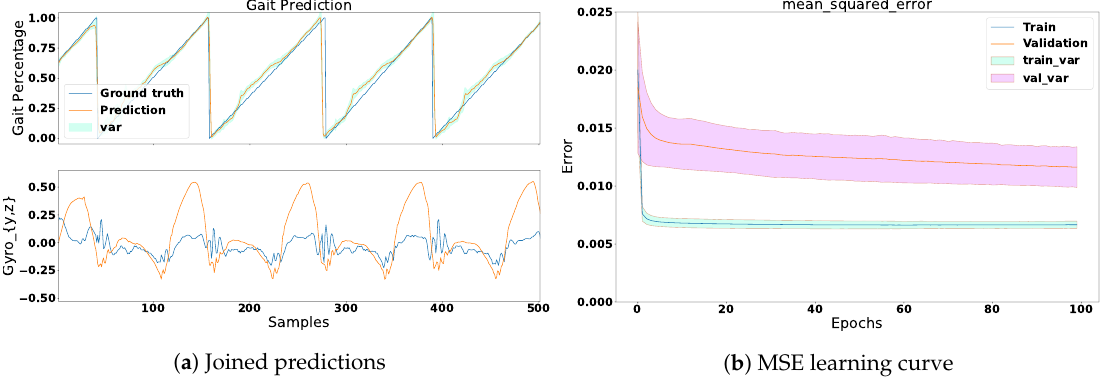
Figure 8. This figure shows the prediction and learning process results of the joined signal for several subjects. Similar to Figure 7, ( a ) shows the comparison between the prediction and the ground truth and ( b ) illustrates the learning curve of the MSE. The average MSE reached a loss of 0.006 in the training set and an average of 0.0115 in the test